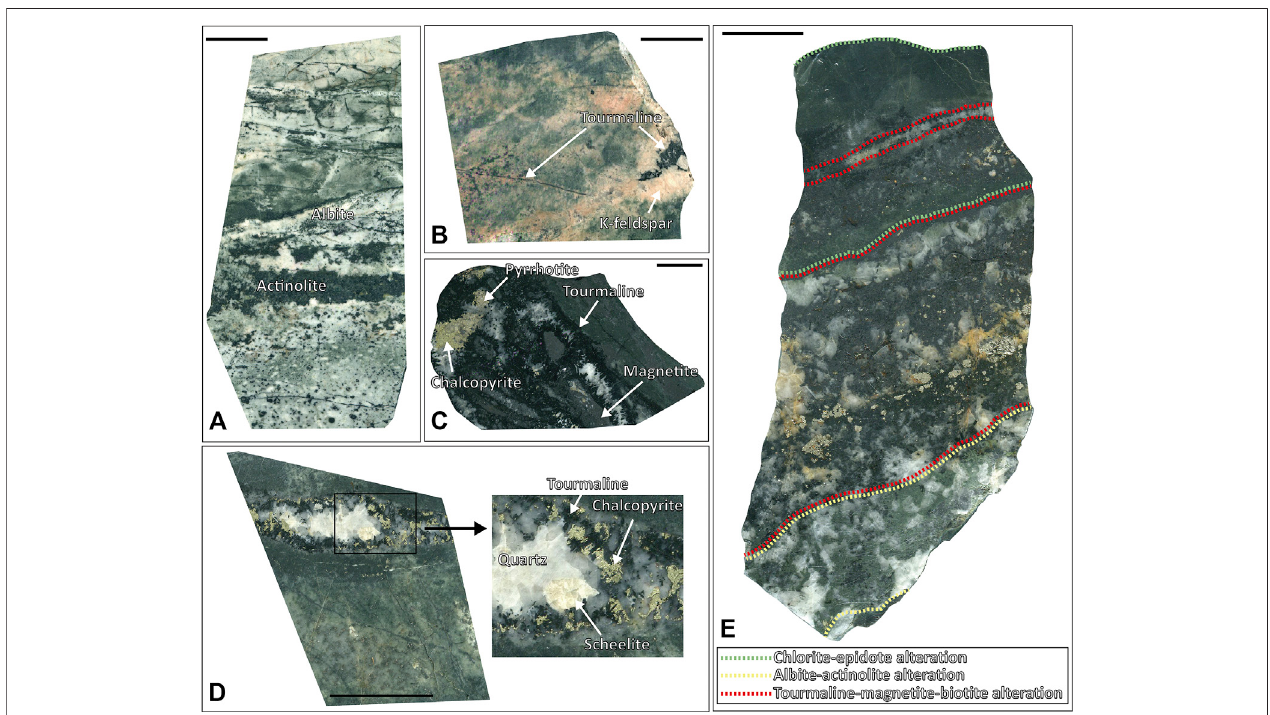
FIGURE 3 | Vein and alteration petrography of the Haman deposit. (A) Quartz veins with albite-actinolite alterations. (B) Quartz veins with a tourmaline-K-feldspar alteration. (C) Quartz veins with tourmaline-magnetite alterations with chalcopyrite and pyrrhotite that cut into chlorite-epidote altered host rock. (D) Quartz veins with tourmalinealterationwithchalcopyriteandscheelite. (E) Thechlorite-epidotealteredhostrockwasoverprintedbyalbite-actinolitealterationsandcutbyquartzveinswith a tourmaline-magnetite-biotite alteration. The green dotted lines represent a chlorite-epidote “ CE ” alteration, the yellow dotted lines represent an albite-actinolite “ AA ” alteration, and the red dotted lines represent a tourmaline-(magnetite)-biotite “ TB ” alteration.